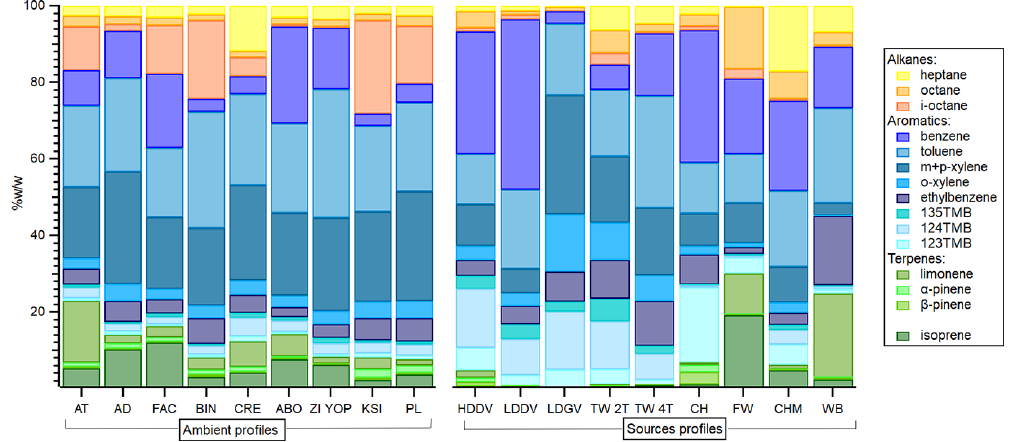
Figure 5. Relative concentration comparison between ambient measurements and emission source profiles of VOCs measured in Abidjan, Côte d’Ivoire. Orange- and yellow-based colours represent the contributions of alkanes, blue-based colour aromatics, and green-based colour terpenes and